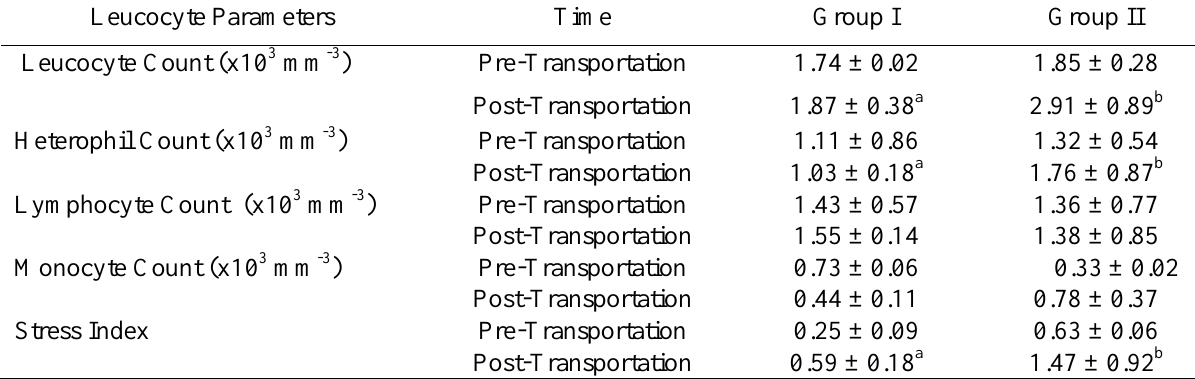
Table 3: Leucocyte parameters of Clarias gariepinus subjected to Road Transportation Leucocyte Parameters